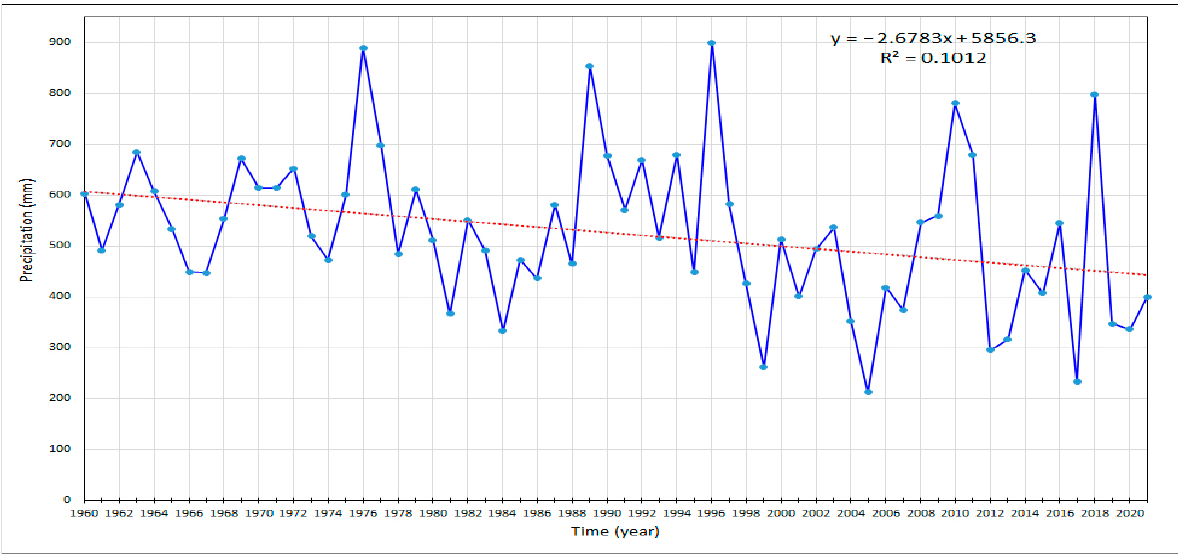
Figure 15. Decreasing trend in precipitation between 1960 and 2021 in the study region .